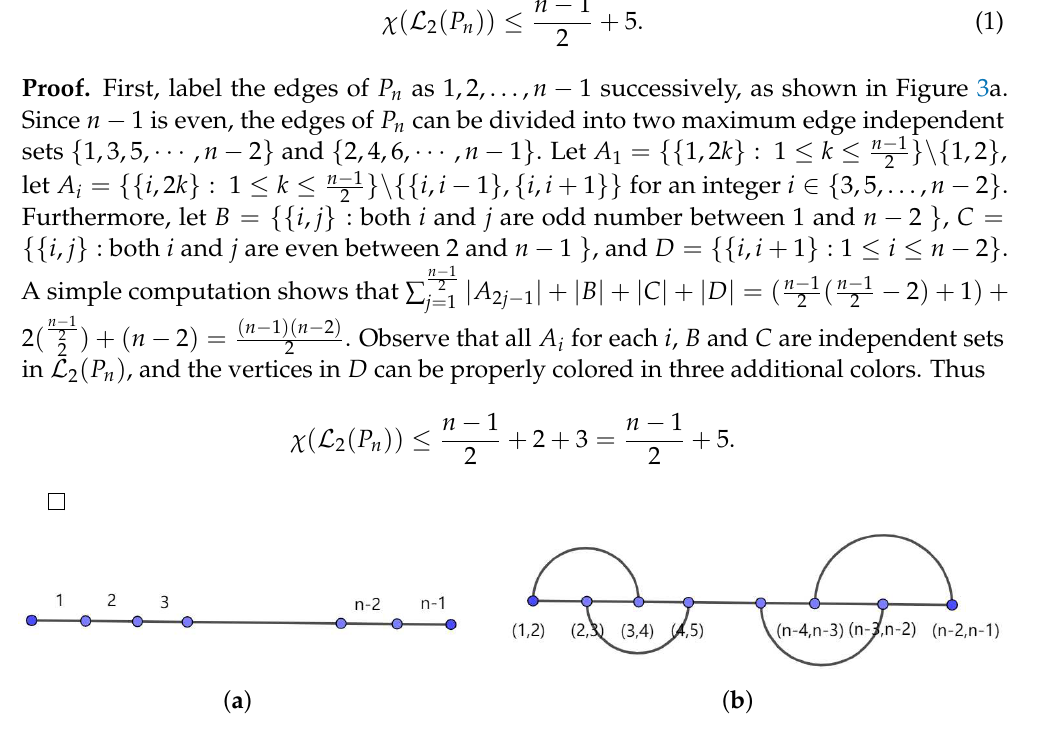
Figure 3. The labeling of edges of P n and L 2 ( P n )[ D ] : ( a ) P n ; ( b ) the subgraph induced by D